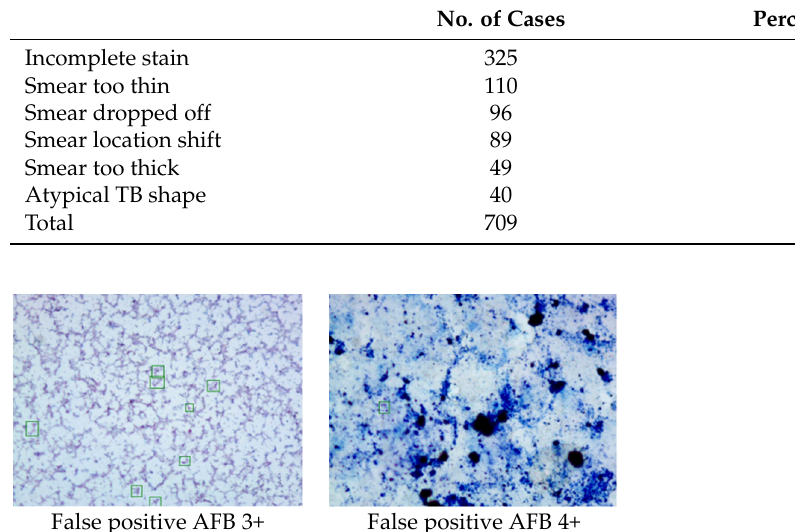
Table 2. The factors that influence the smear microscopy.